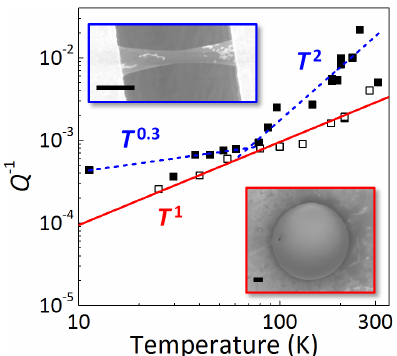
Figure 5. (Color online) Temperature-dependent energy dissipation ( Q − 1 - T ) of our doubly-clamped trilayer graphene resonators (solid squares) and drumhead monolayer graphene resonators (open squares). Blue dashed and red solid lines show linear fittings for doubly-clamped and drumhead graphene resonators, respectively. Insets show SEM images of our trilayer doubly-clamped resonators and monolayer drumhead resonators. Scale bars are 2.5 µ m. Reproduced from [12], with the permission of AIP Publishing.